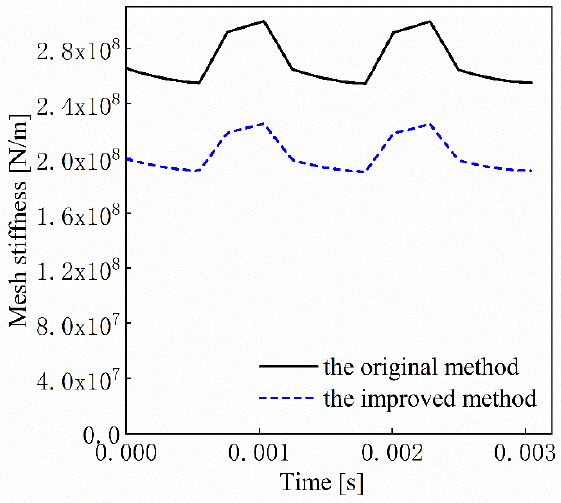
Figure 5. The mesh stiffness of cracked gear pair when axial force is considered and neglected.